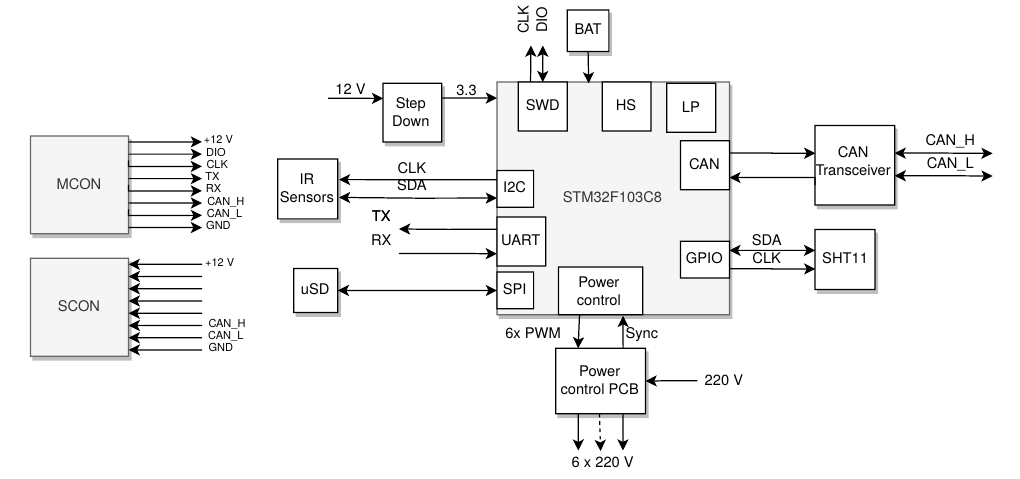
Figure 6. A schematic diagram of the ARM-Node. Description in